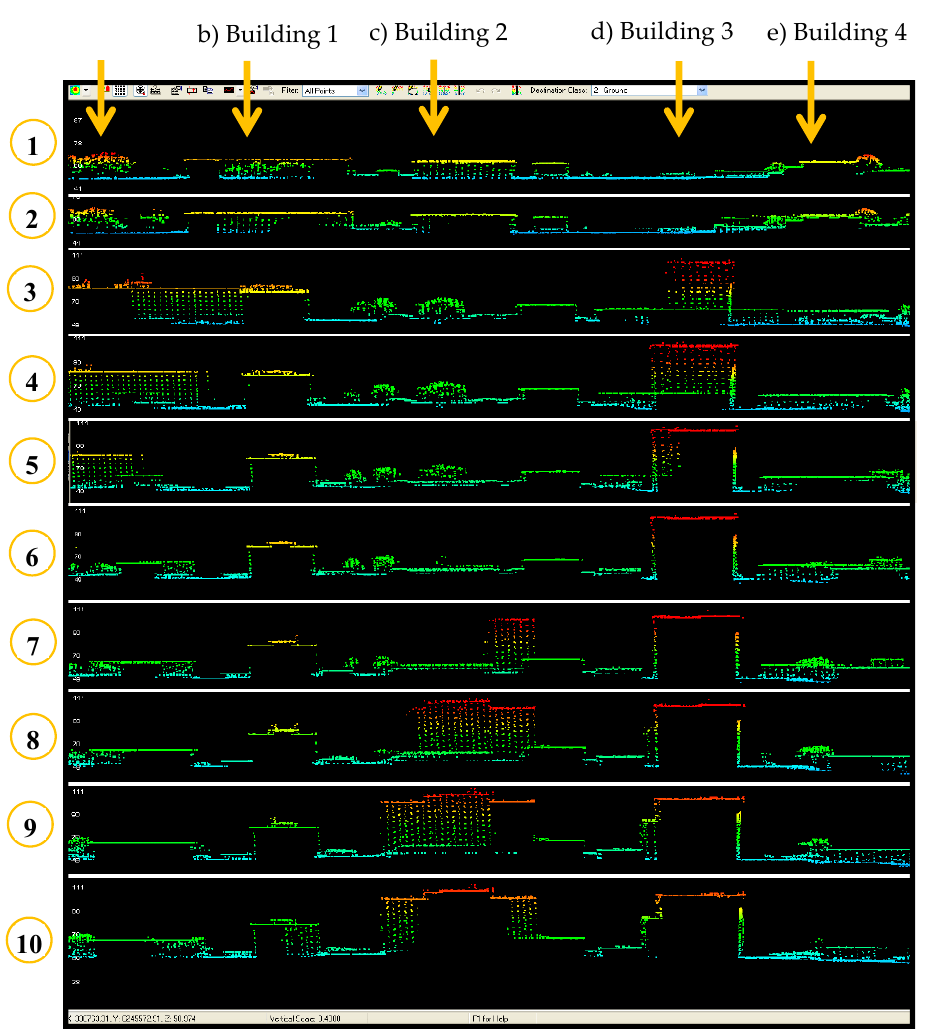
Figure 7. Visualisation of the slant area in ten profiles created by 1 m stepping between windows. Note: Each number from 1 to 10 refers to a single profile. As an example, the tall building, namely Building 3, is shown in profiles 3 to 10, but can be seen as a short building in profiles 1 and 2. Trees also appear in profiles 3 to